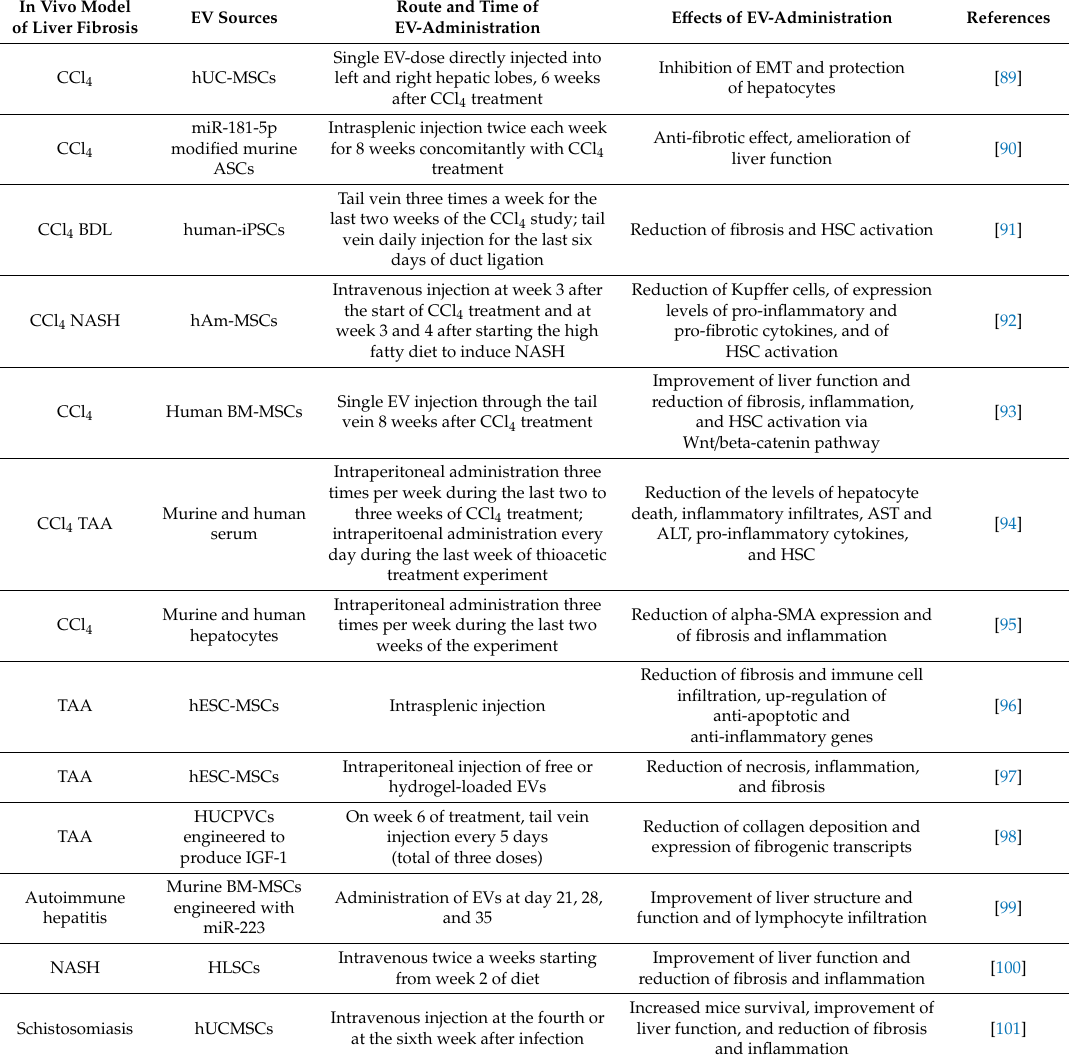
Table 2. E ff ects of EVs of di ff erent origins on di ff erent models of fibrotic liver damages. NASH, non-alcoholic steato-hepatitis; TAA, thioacetamide; HUCPVC, human cord perivascular cell; IGF, insulin-like growth factor; EMT, epithelial-to-mesenchymal transition; SMA, smooth muscle actin. Route and Time of In Vivo Model E ff ects of EV Sources EV-Administration of Liver Fibrosis